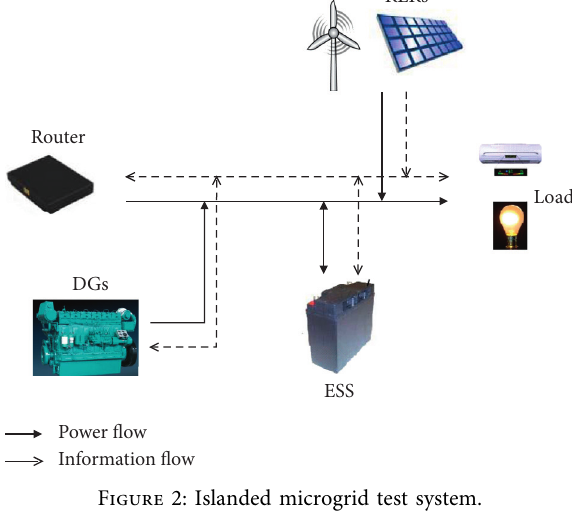
Figure 2: Islanded microgrid test system.